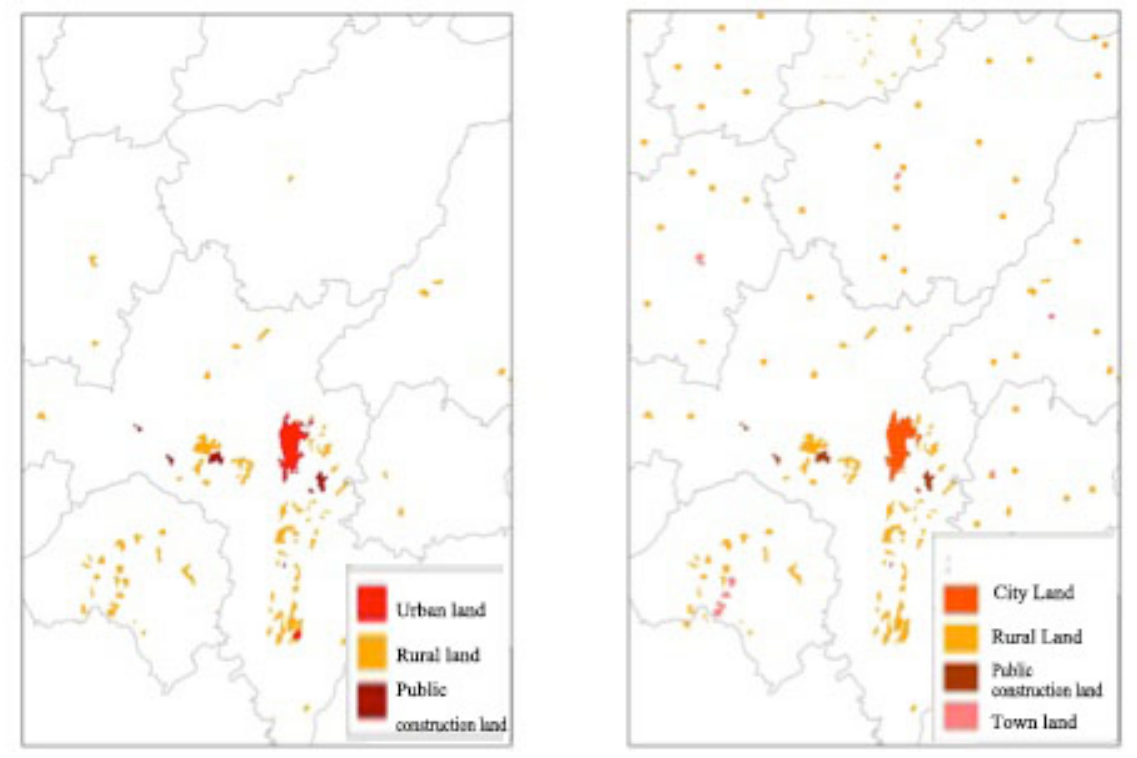
Figure 5 Comparison before and after Correction result near to Dongchuan Yunnan province (Left: original land using data, Right: correction result)